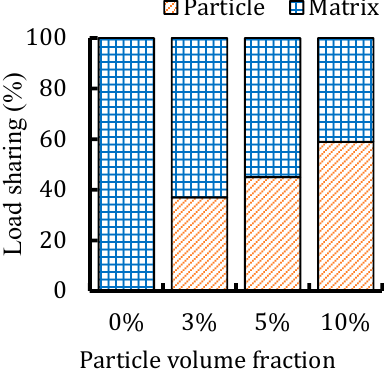
Figure 7. Load sharing capacity of the PLLA/420SS composites.